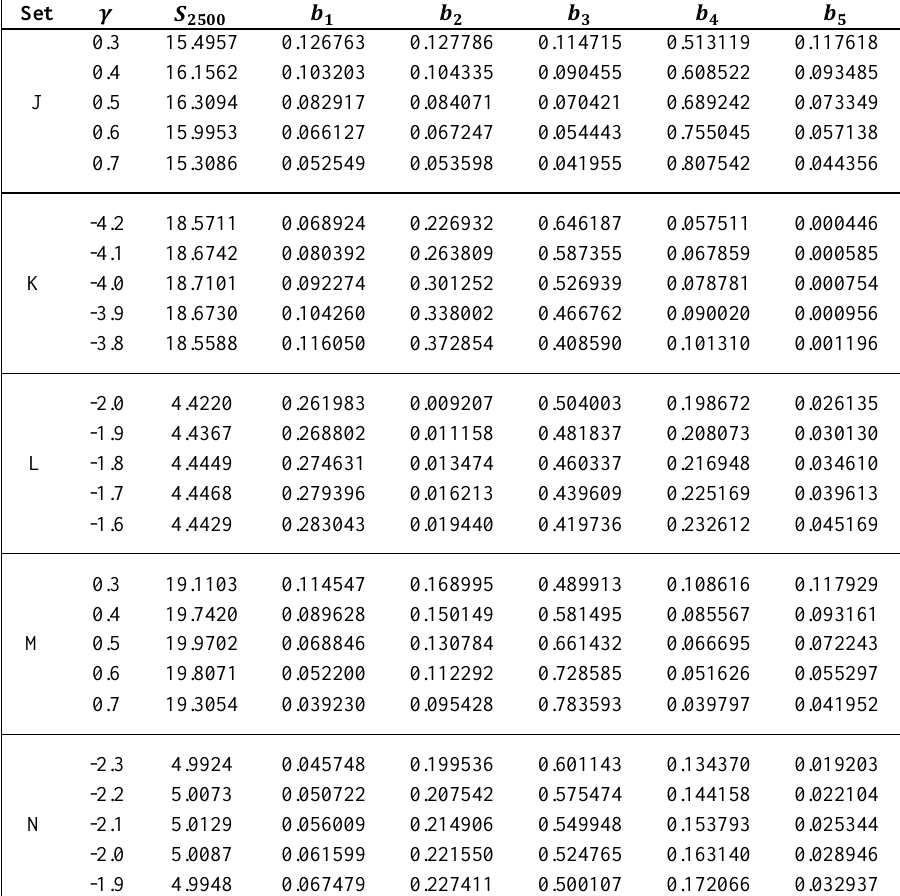
Table 2. The best wealth 𝑆 2500 obtained after 2500 trading days by running the Type 1 Helmbold portfolio (see [4]) over the data set J, K, L, M, N for selected value of 𝛾 and the final portfolios after 2500 trading days 𝒃 2501 are listed.